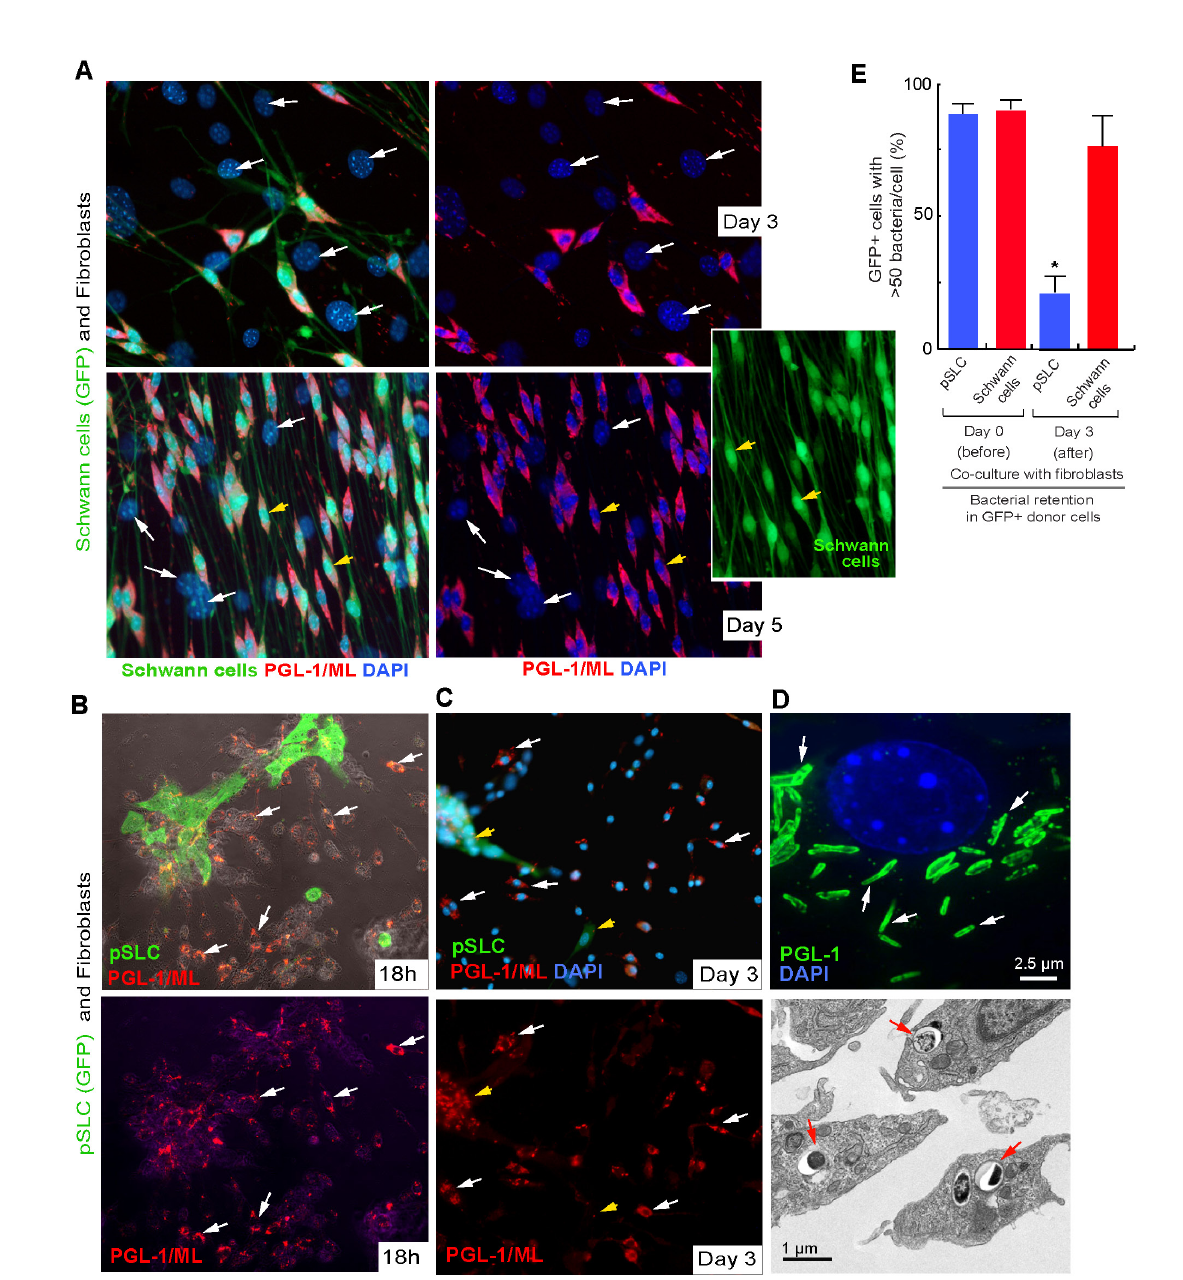
Figure 3. Reprogramming significantly reduces ML retention capacity of adult Schwann cells and elevates bacterial transfer property to fibroblasts. ( A ) De-differentiated Schwann cells purified from adult peripheral nerves from GFP mice were infected with ML for 3 days and incubated with fibroblasts (isolated from wild type/non-GFP peripheral nerves) for another 3 (top panel) and 5 (bottom panel) days. Fixed co-cultures were labelled with antibody to ML-specific PGL-1 (red) and nuclei were counter stained with DAPI (blue). White arrows show non- GFP fibroblasts with very few ML transferred from GFP+ Schwann cells. Note that almost all GFP+ Schwann cells carry high number of ML (yellow arrows). Inset shows GFP+ Schwann cells with typical bipolar morphology with content of ML (same as in bottom panel). ( B , C ) GFP+ reprogrammed Schwann cells, pSLC effectively transfer ML to exogenously added fibroblasts. GFP-pSLC were co-cultured with fibroblasts and fixed after 18h ( B ) and 3 days ( C ) and labelled with anti-PGL1 antibody. In B (top) shows the phase-contrast image and in C (top) cells are counterstained with DAPI (blue). Note that numerous ML were transferred to fibroblasts within 18h; arrows in B , C show PGL-1+ ML in non-GFP fibroblasts. Yellow arrows mark the GFP+pSLC ( B , C ). Magnification: ( A , B , C ) 20x. ( D ) Representative high-resolution confocal image (top) showing PGL-1 antibody-reactive intact rod-shaped ML (green; arrows) within fibroblasts (nucleus is labelled by DAPI; blue), and electron micrograph illustrating whole ML with electron transparent outer lipids (red arrows) in the cytoplasm of fibroblasts (bottom). ( E ) Quantitative analysis of bacterial retention in GFP+ non-reprogrammed Schwann cells as compared to GFP+ reprogrammed Schwann cells/pSLC in the presence of fibroblasts. * < p